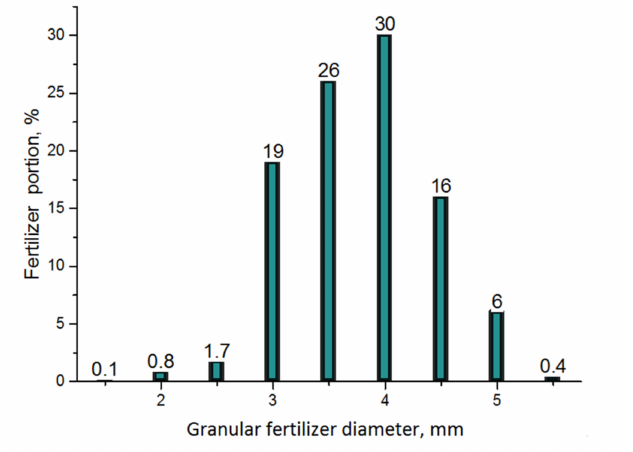
Figure 11. The size distribution of the granular fertilizer generated on EDEM.